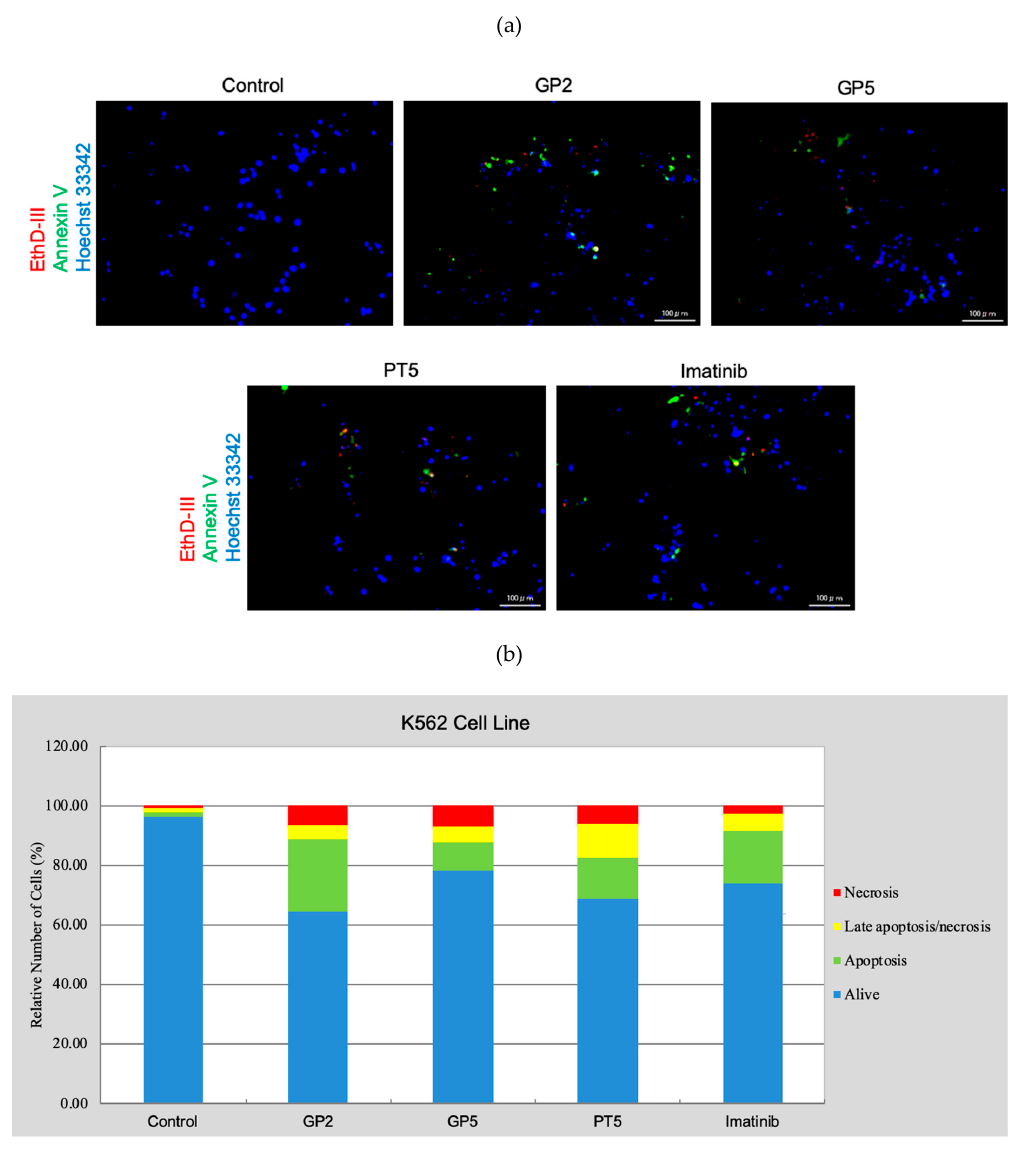
Figure 2. Alteration in K562 cells at IC 50 concentrations of control, GP2 , GP5 , PT5 and imatinib for 8 h. ( a ) Fluorescent microscopic images. ( b ) A total of approximately 100 stained cells was selected randomly in each experiment of ( a ) and were classified into 4 types “alive” (blue), “apoptosis” (green), “necrosis or late apoptosis” (both green and red, yellow) and “necrosis” (red). As a consequence of the central role of ABL kinase in cellular processes including cell replication and apoptosis, GP2 , GP5 and PT5 were selected for further investigation of the potential inhibitory activity against ABL kinase using multipoint dose-response experiments (Table 3). Among them, PT5 was found to be the most potent ABL kinase inhibitor with the IC 50 value of 1.44 μ M, followed by GP5 and GP2 with IC 50 values of 6.16 μ M and 7.19 μ M, respectively. IC 50 of PT5 is six times stronger than 1c . Although it is still incomparable to imatinib (IC 50 0.21 μ M), they showed similar cellular activity (IC 50 ~5.5 μ M) against K562 cells (Table 1) and similar selectivity against various cancer cell lines (Table 2). PT5 is considered to express more efficient cellular activity, but the detailed reason remains elusive.